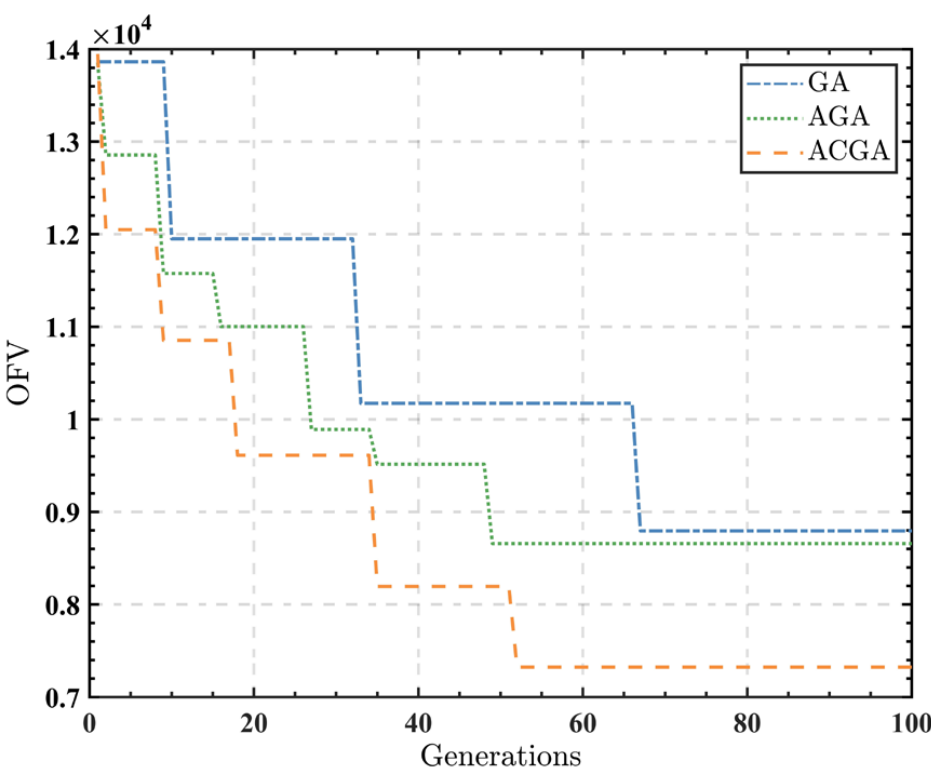
Figure 11 shows the convergence effect of Example 10. The blue line shows the convergence curve of the GA, the green line shows the convergence curve of the AGA, and the orange line shows the convergence curve of the ACGA. As can be seen from the graph, the ACGA and the AGA converge at around 50 generations, both converging faster than the GA, at around 70 generations. At the same time, the ACGA has a significantly lower DCRC total running time and better solution results. The experimental results show that the ACGA can find near-optimal solutions in a short time and has better global search capability. Therefore, the ACGA is used next in solving large-scale algorithms.